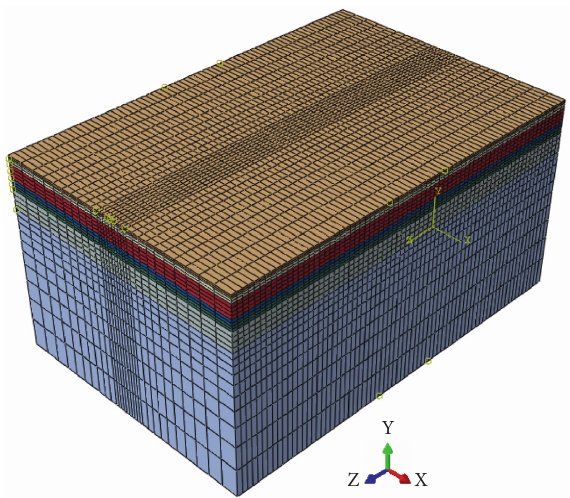
Figure 4: Grid division of the 3D